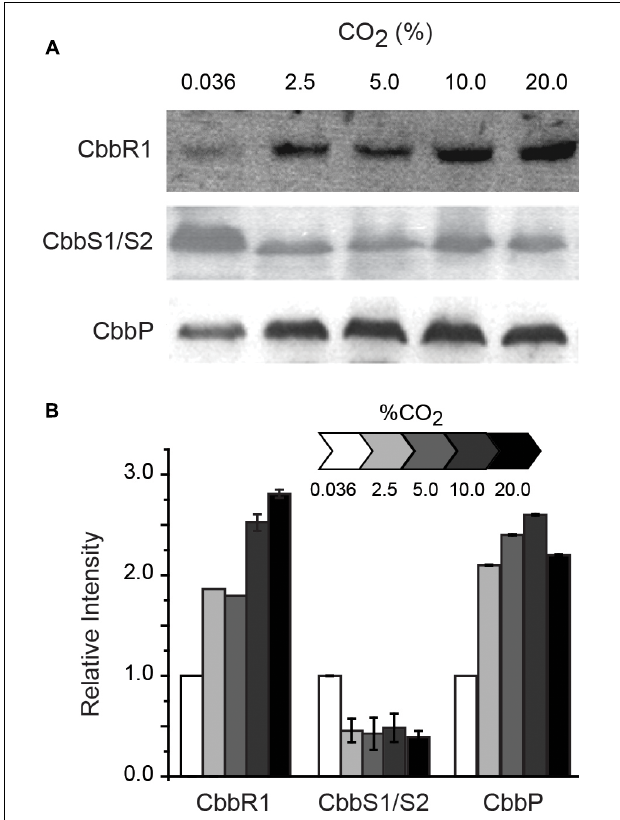
FIGURE 3 | (A) Representative Western blots (of duplicates) of CbbR (cbb operon 1), CbbS1/S2 (the antibody used in the assay cannot distinguish between the two proteins) (cbb operon 1 and/or 2), and CbbP (cbb operon 4). (B) Quantification of the intensity of the Western blots relative to expression in 0.036% CO 2 normalized to 1. Cells were grown in different concentrations of CO 2 as indicated above the Western blots in (A) and in the scale bar in (B) . Error bars depict ranges of duplicate